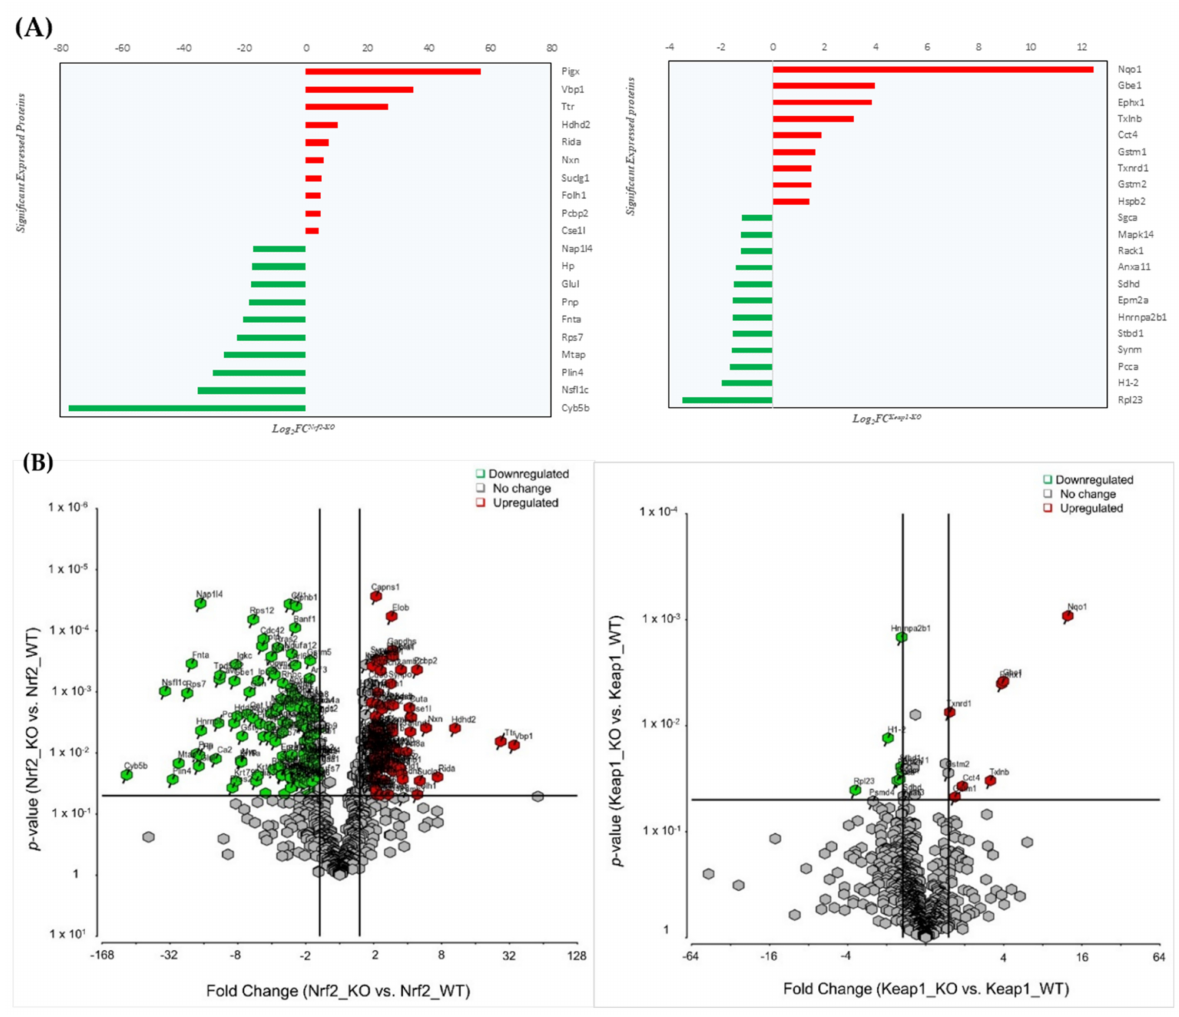
Figure 1. Schemes follow the same formatting. Mass spectrometry-based proteomics analysis of muscles in Nrf2-KO, Nrf2- WT, Keap1-KO, and Keap1-WT mouse models. ( A ) Left panel: top 10 significantly upregulated (red) and downregulated (green) proteins in Nrf2-KO/WT muscles; Right panel: Top 10 significantly upregulated (blue) and downregulated (red) proteins in Keap1-KO/WT muscles. ( B ) Volcano figure plots showing the log2 fold change (WT/KO) plotted against the –log10 p value, highlighting significantly changed proteins (red and green; p ≤ 0.05 and an absolute fold change of 1.5, n = 4, moderated t -test). The vertical lines correspond to the absolute fold change of 1.5, and the horizontal line represents a p value of 0.05. Log 2 fold changes in Nrf2-KO and Keap1-KO knockouts are represented as Log 2 FC Nrf2-KO and Log 2 FC Keap1-KO ,